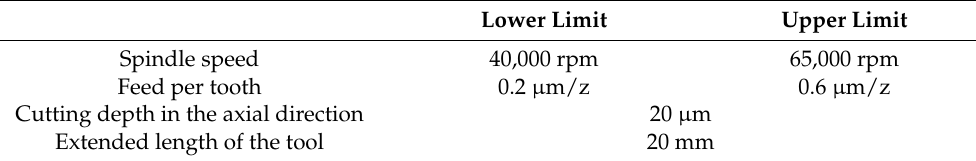
Table 2. Process window.